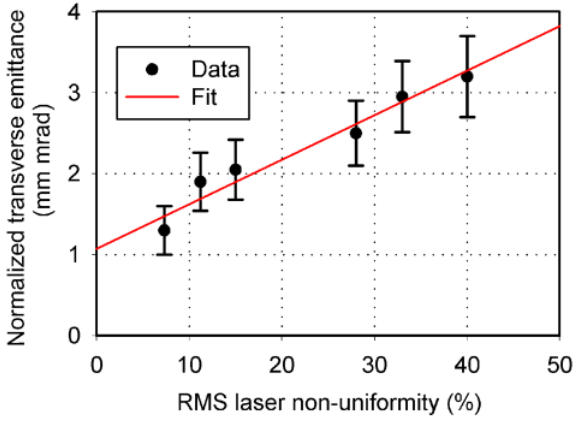
FIG. 6. (Color) Emittance as a function of laser rms nonun- iformity.